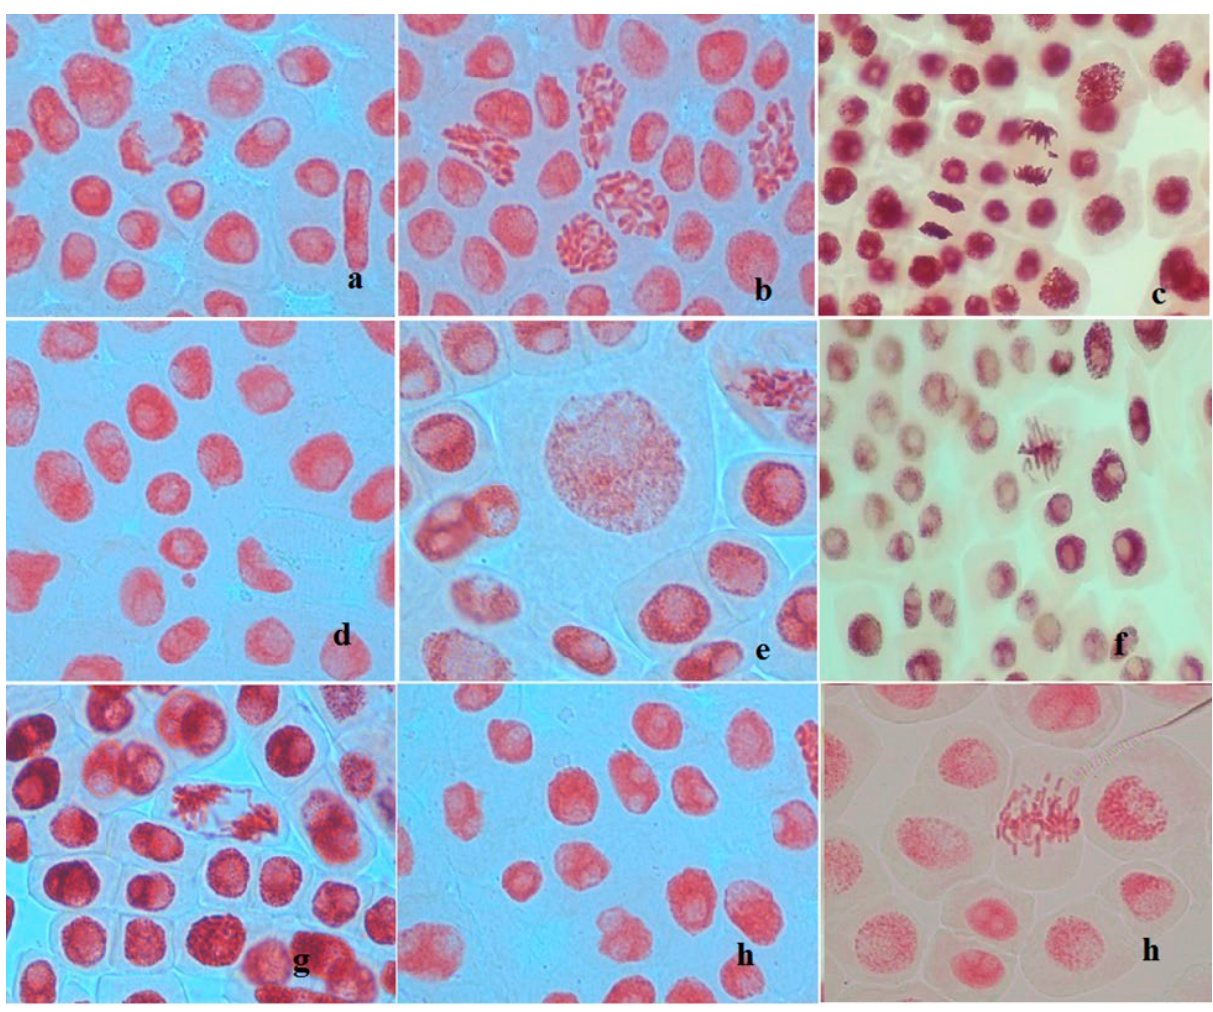
Figure 4. Chromosomal aberrations and nuclear abnormalities identified in meristematic root cells of A. cepa L . (a) telophase bridge – L 5% 24h; (b) C-mitosis – L 5% 48h; (c) laggards – L 5% 24h; (d) micronucleus and nuclear buds - L 5% 48h; (e) giant cell – L 10% 48h; (f) vagrant – L 10% 24h; (g) anaphase bridges – L 15% 24h; (h) altered nuclear shape – L 10% 48h; (h) fragments – L 5%